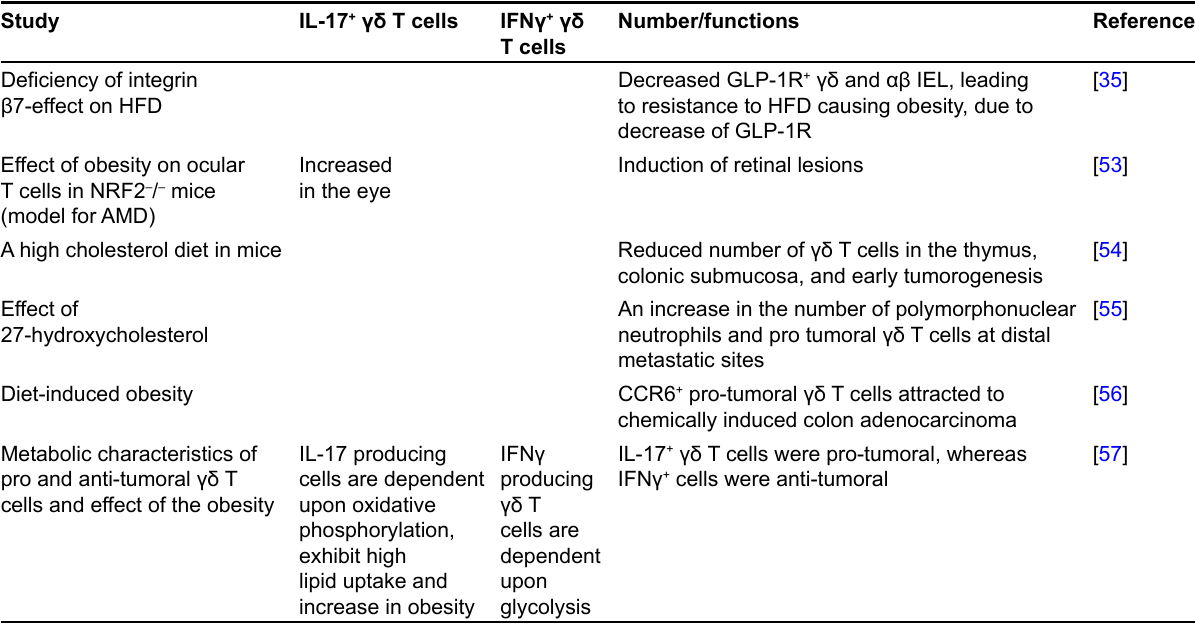
Table 1. Murine models: γδ T cells in AT and adiposity ( continued )